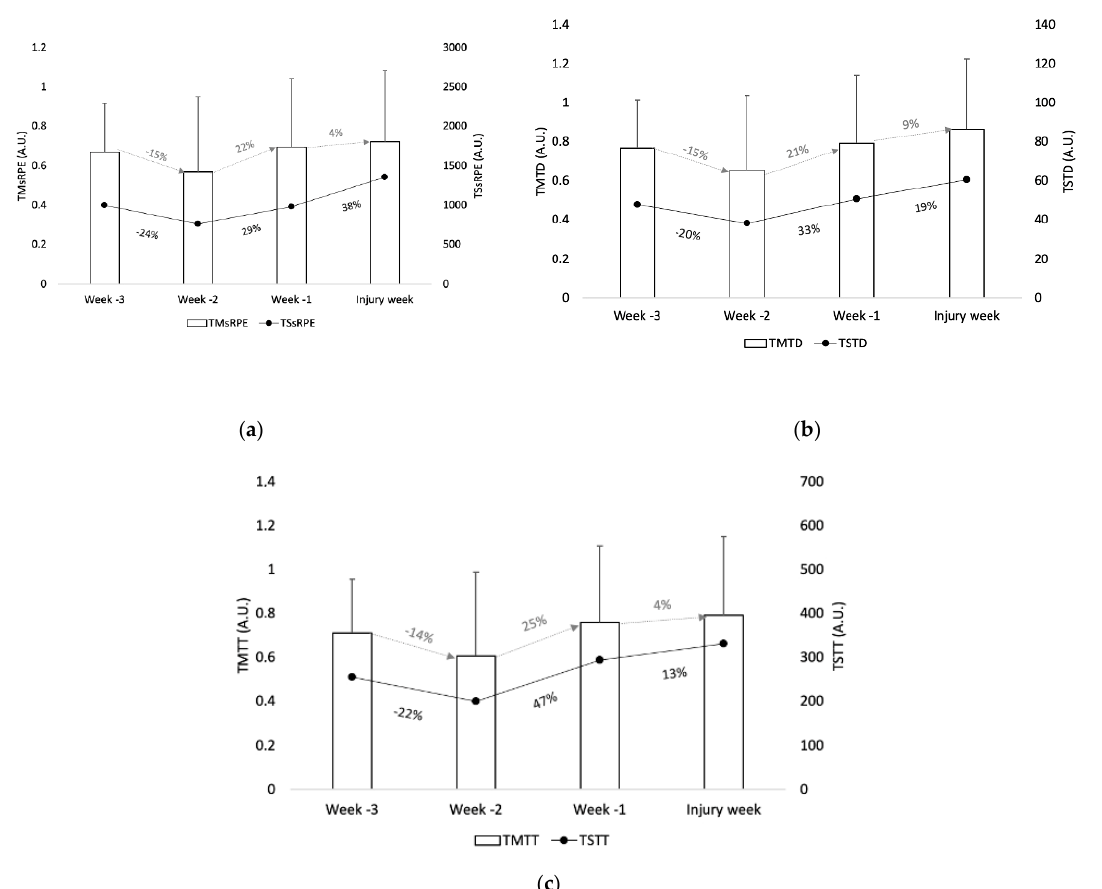
Figure 2. Descriptive statistics (error bar: mean and standard deviation of training monotony; black circle: mean of training strain) of ( a ) sRPE, ( b ) total distance (TD), and ( c ) training time (TT) in the three weeks (w) prior injury occurrence. The grey number (%) represents the percentage of changes from one week to another for training monotony and the black number (%) represents the percentage of change from one week to another in training strain.